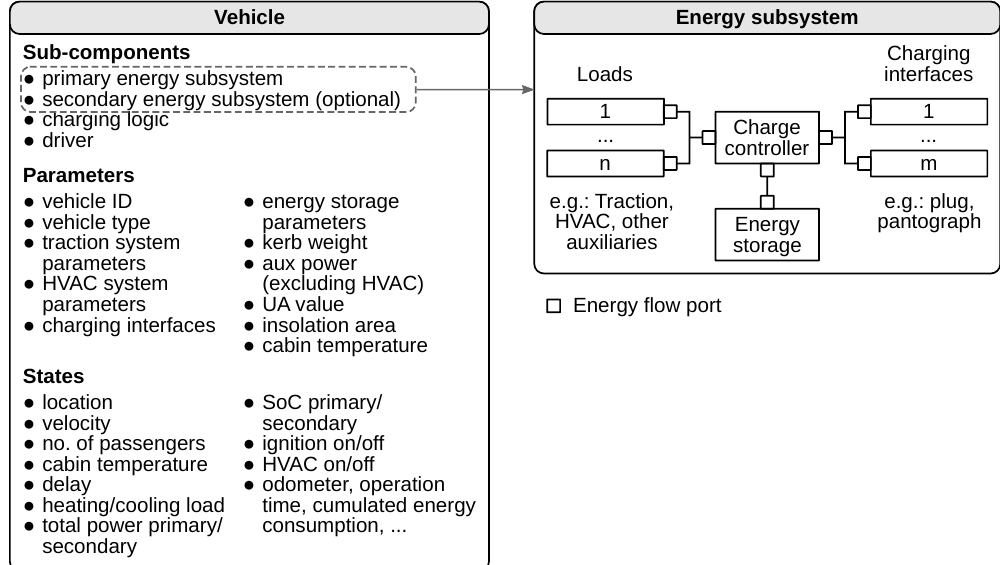
Figure 5. Vehicle and energy subsystem